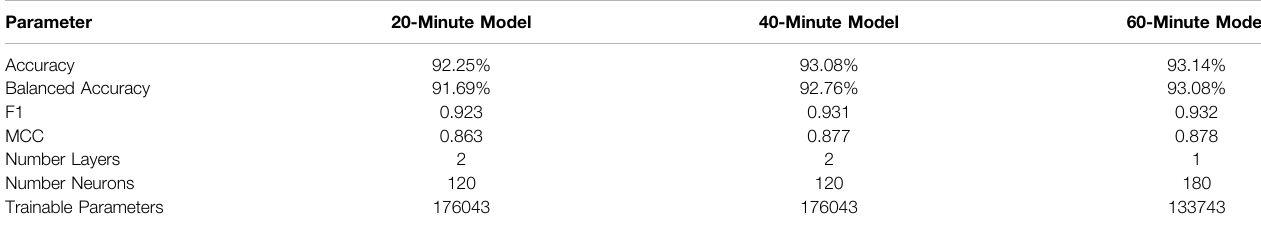
TABLE 3 | Comparison of RNN model performance for differing time sequence lengths as well as relevant model